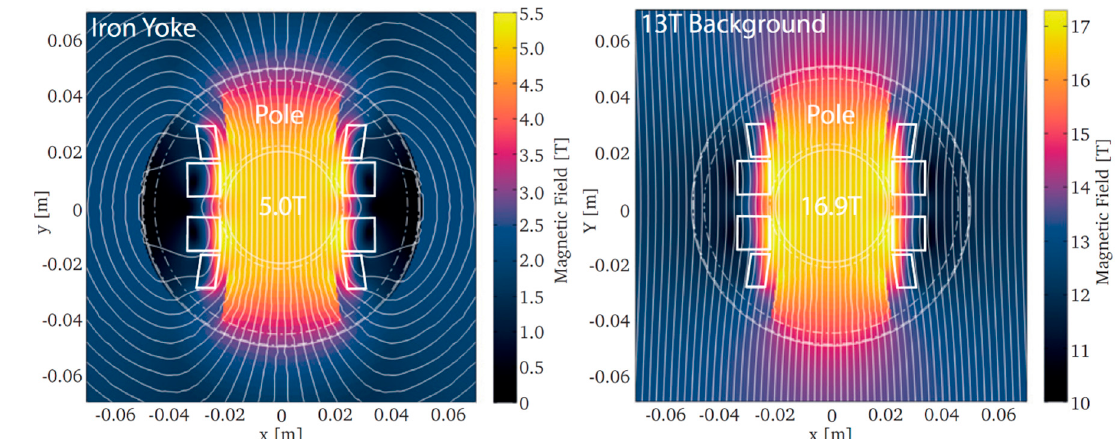
Figure 16. Cross-section of the coils of the Aligned Block dipole. The alignment is optimized when the dipole is inserted in the Fresca2 background field (see plot at the right), so is not as good as when the dipole is powered in standalone mode (left plot), [65].